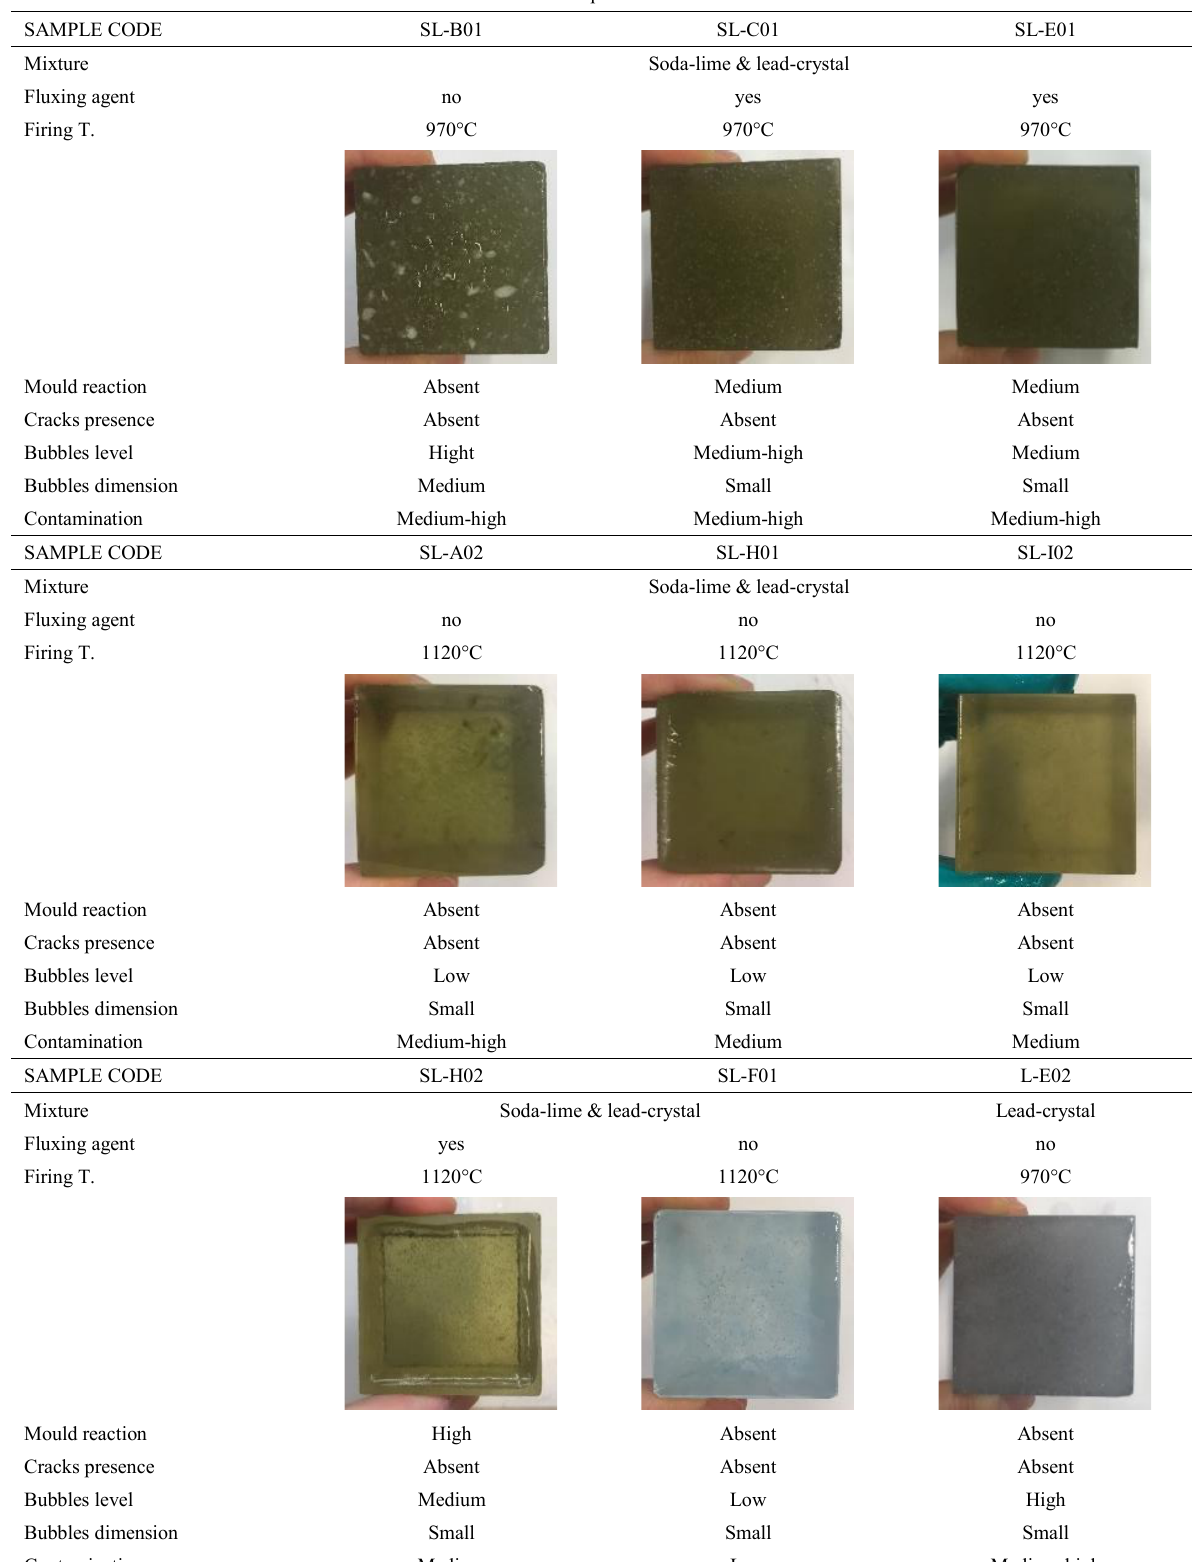
Table 4: Samples